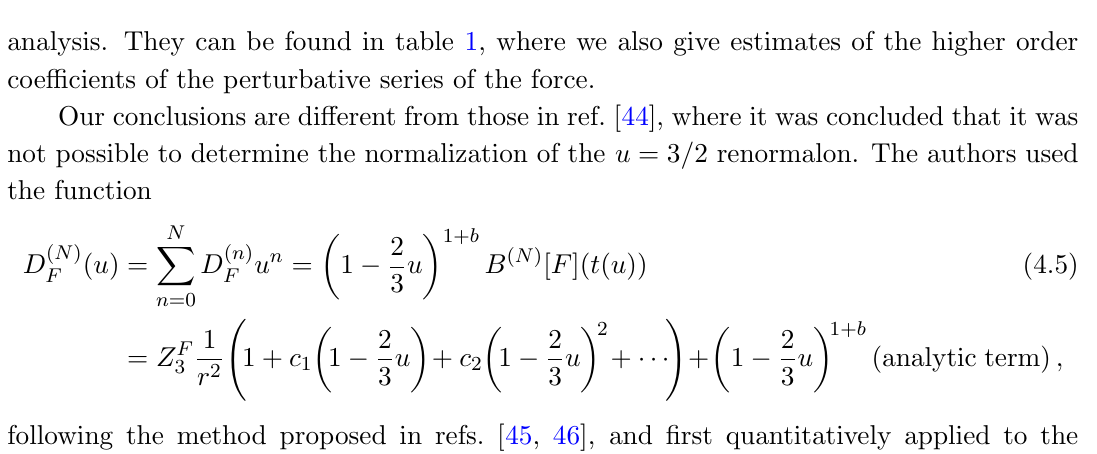
using f n =f ( as ) n Z F as a function of (cid:22)r and for di(cid:11)erent 3 3 using eq. (4.6). Upper 3